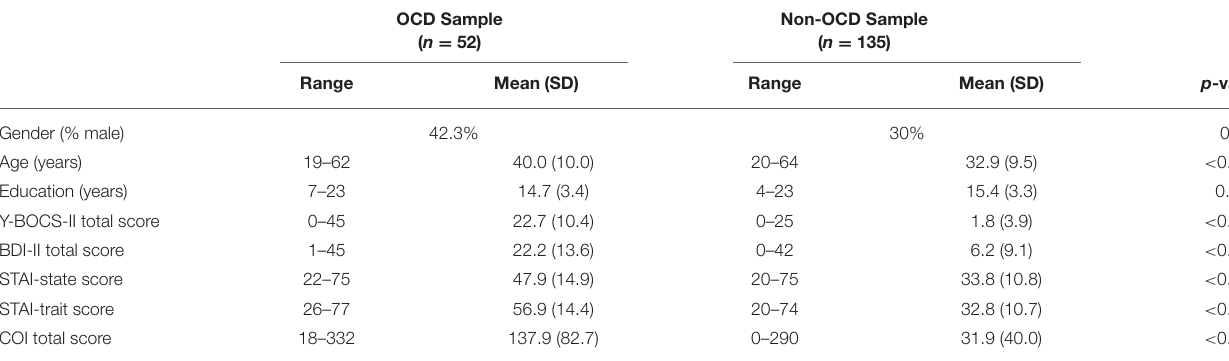
TABLE 1 | Sociodemographic and psychometric data from each sample.